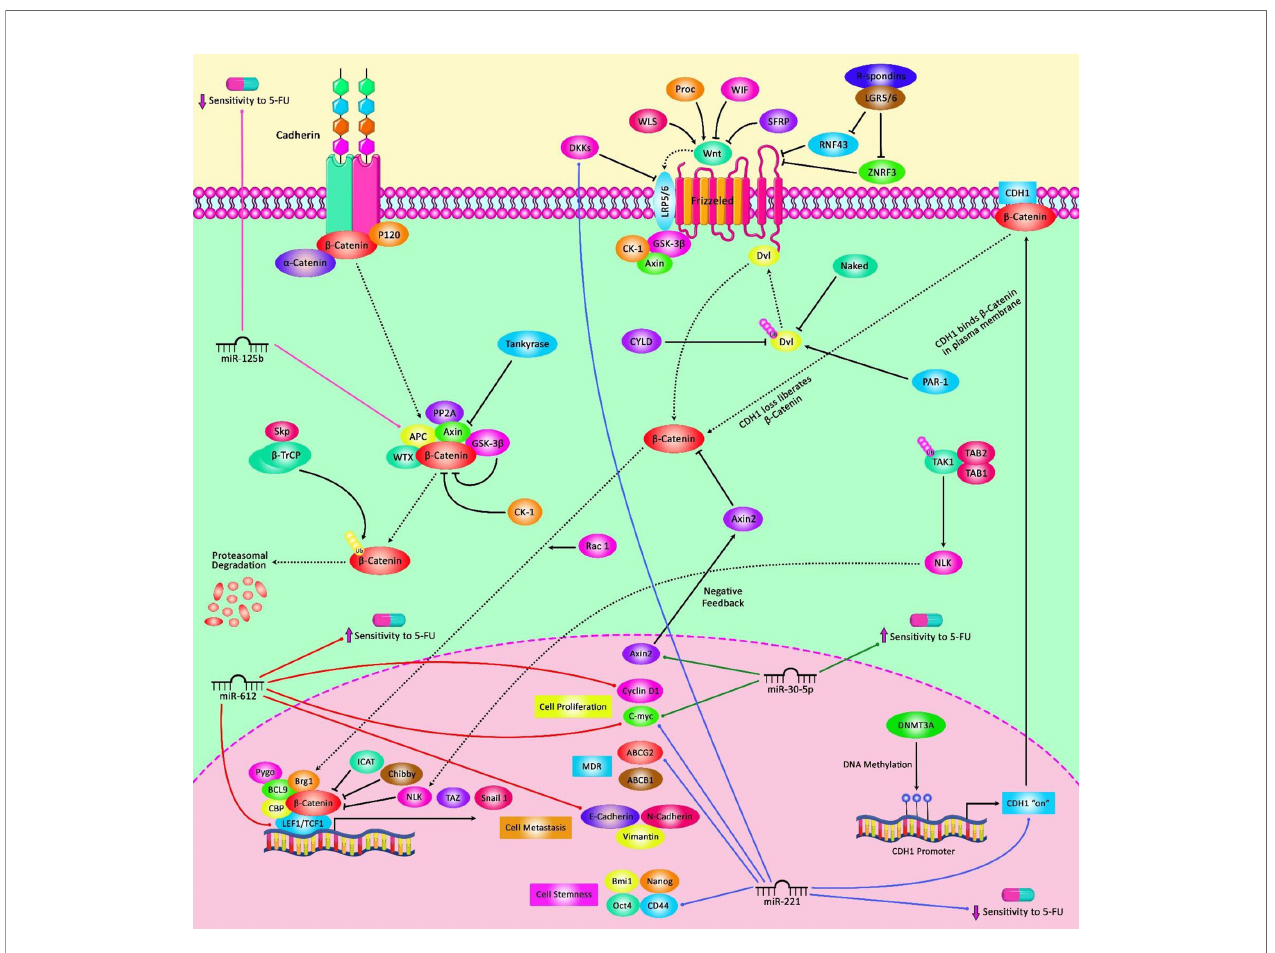
FIGURE 1 | A schematic representation of the crosstalk between microRNAs and the Wnt/ b -catenin pathway contributing in the modulation of 5-FU in the cancer cell. Mounting evidence has indicated that microRNAs dysregulation and the Wnt/ b -catenin signaling pathway jointly drive the regulation of the sensitivity of tumor cells to 5-FU as a chemotherapeutic agent. As an illustration, miR-30-5p has been detected to function as a tumor suppressor via regulating the Wnt/ b -catenin signaling cascade in colorectal cancer cells. miR-30-5p could downregulate the expression level of Wnt/ b -catenin signaling target genes (MYC and Axin2) and the levels of b -catenin protein, thereby promoting the sensitivity of these target cells to 5-FU agent (48). Besides, miR-125b is a critical downstream mediator of the CXCL12/CXCR4 axis which could activate the Wnt/ b -catenin signaling via targeting the APC gene and could play an effective role in enhancing invasion and 5-FU resistance by elevating autophagy in colorectal cancer cells